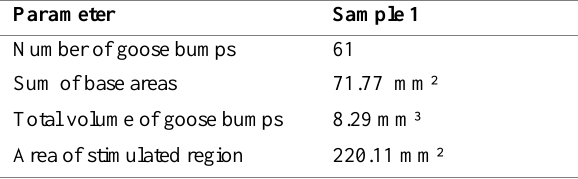
Table 2. Relevant parameter values as result of a sample with obvious structured goose bumps (compare Fig. 6e)